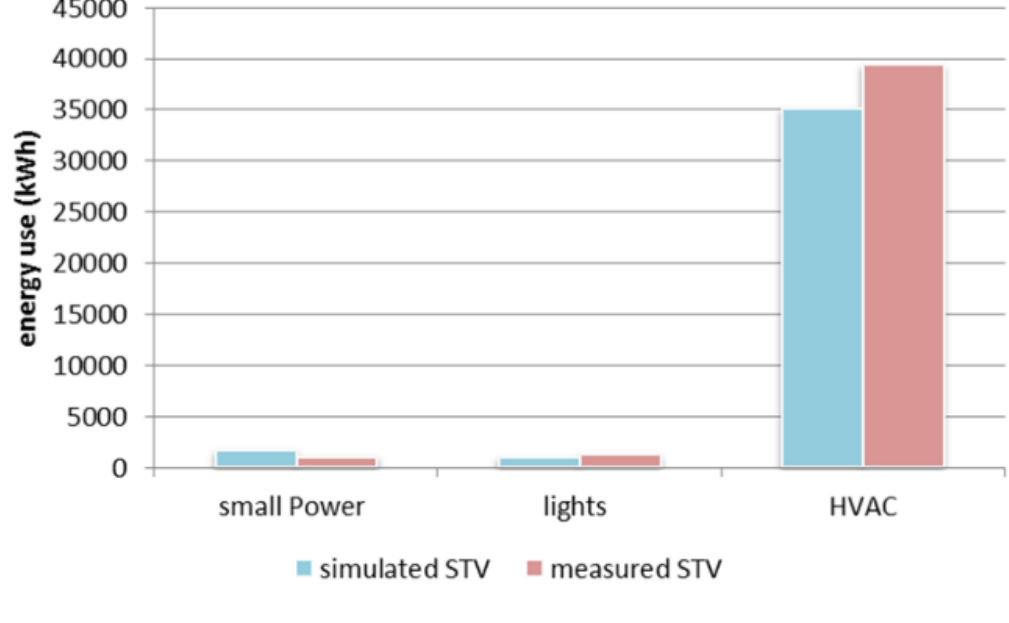
Figure 5. STV simulated and measured energy use